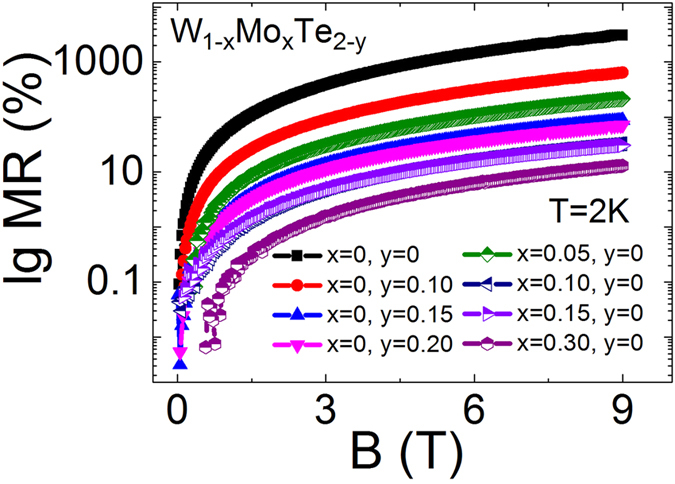
The relationship between MR and magnetic field in WTe2−y (y = 0, 0.10, 0.15, 0.20) and W1−xMoxTe2 (x = 0, 0.05, 0.10, 0.15, 0.30) crystals measured at 2 K.